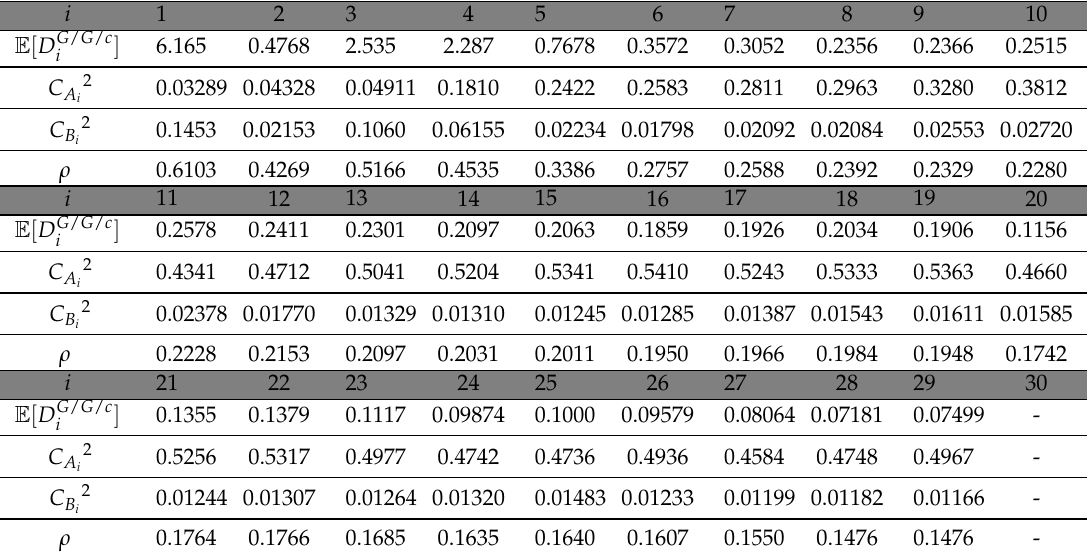
Table 5. Aircraft arrival delay and parameters of the G / G / c model for airspace capacity c = 3 and arrival rate = 30 aircraft per hour.